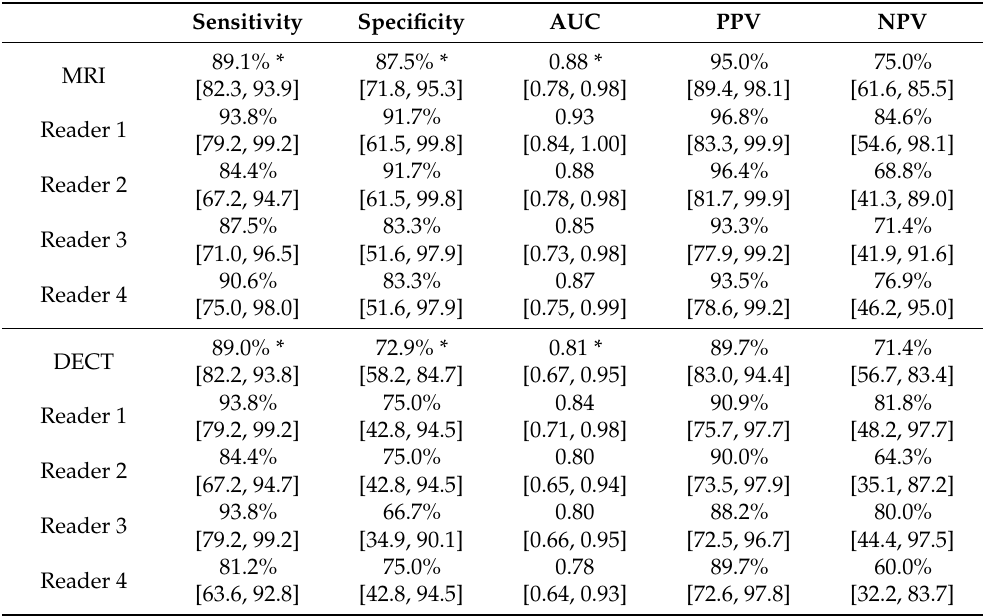
Table 2. Diagnostic performance of four readers at DECT versus MRI for diagnosing presence of